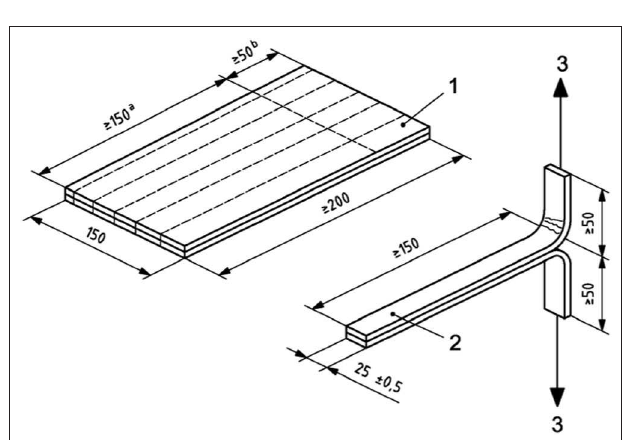
FIGURE 2 | Sample geometry for the T-peel adhesion